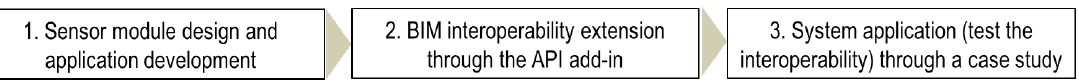
Figure 1. Overview of research methodology.